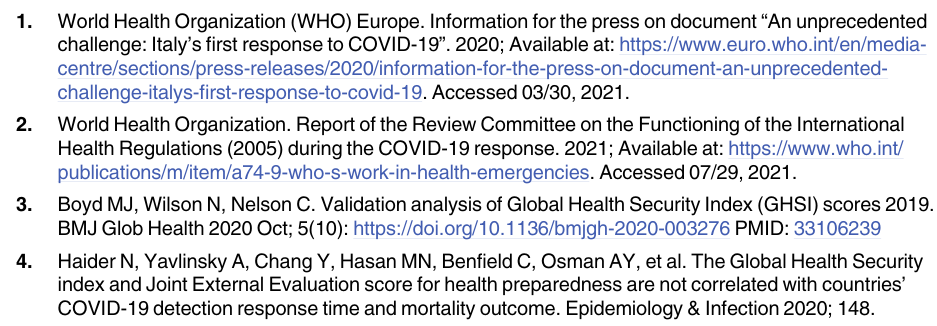
S3 Table. Multivariable linear regression models: The association between JEE score and log COVID-19 deaths at 3 months. S4 Table. Multivariable linear regression models: The association between JEE score and log COVID-19 deaths at 6 months. S5 Table. Multivariable linear regression models: The association between JEE score and log COVID-19 deaths at 12 months. S6 Table. Multivariable linear regression models: The association between JEE score and log communicable disease deaths